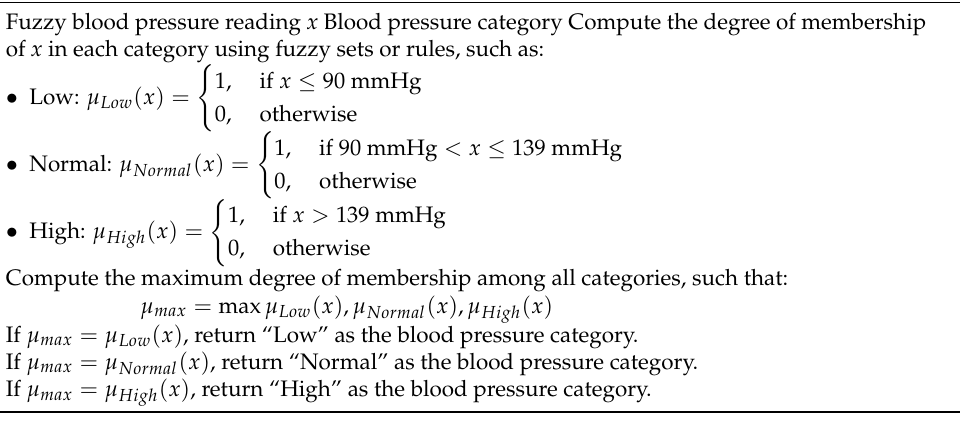
Algorithm 1. Defuzzification for blood-pressure